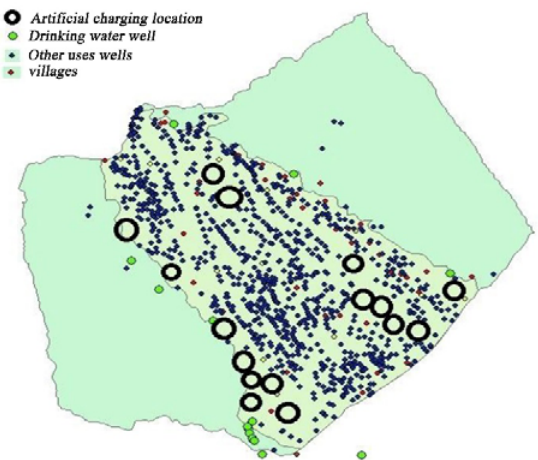
Figure 2. The initial 16 points with the potential for recharge in the